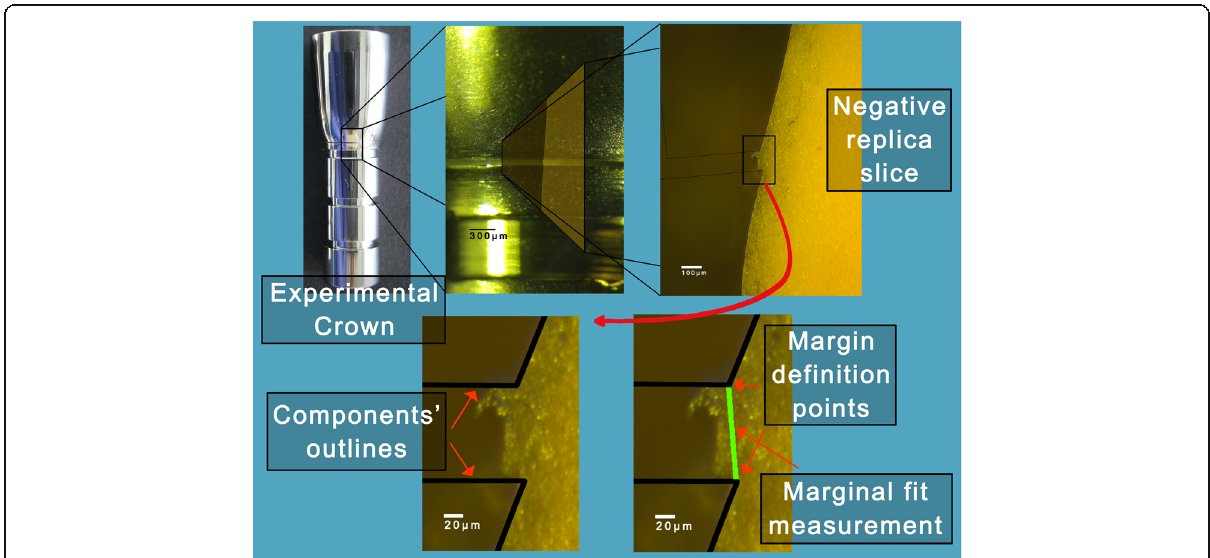
Fig. 3 Digital Image Analysis Sequence: Images on the top raw from left to right: First, a cemented experimental crown, focus on the exposed cement surface at the margin. Second, the superimposed acquired image of the negative replica slice representing a profile parallel to the long axis of the sample and perpendicular to the margin. Next, the captured image of the negative replica slice with the superimposed components outlines (thin black lines) placed at the location of best perceived fit. Images on the bottom raw: Focus on the margin with the components ’ outlines shown with thick lines. The crown outline (angled line on top) and the abutment outline (angled line at bottom). Next, the green line represents the measurement of MF accurately defined between the two angle